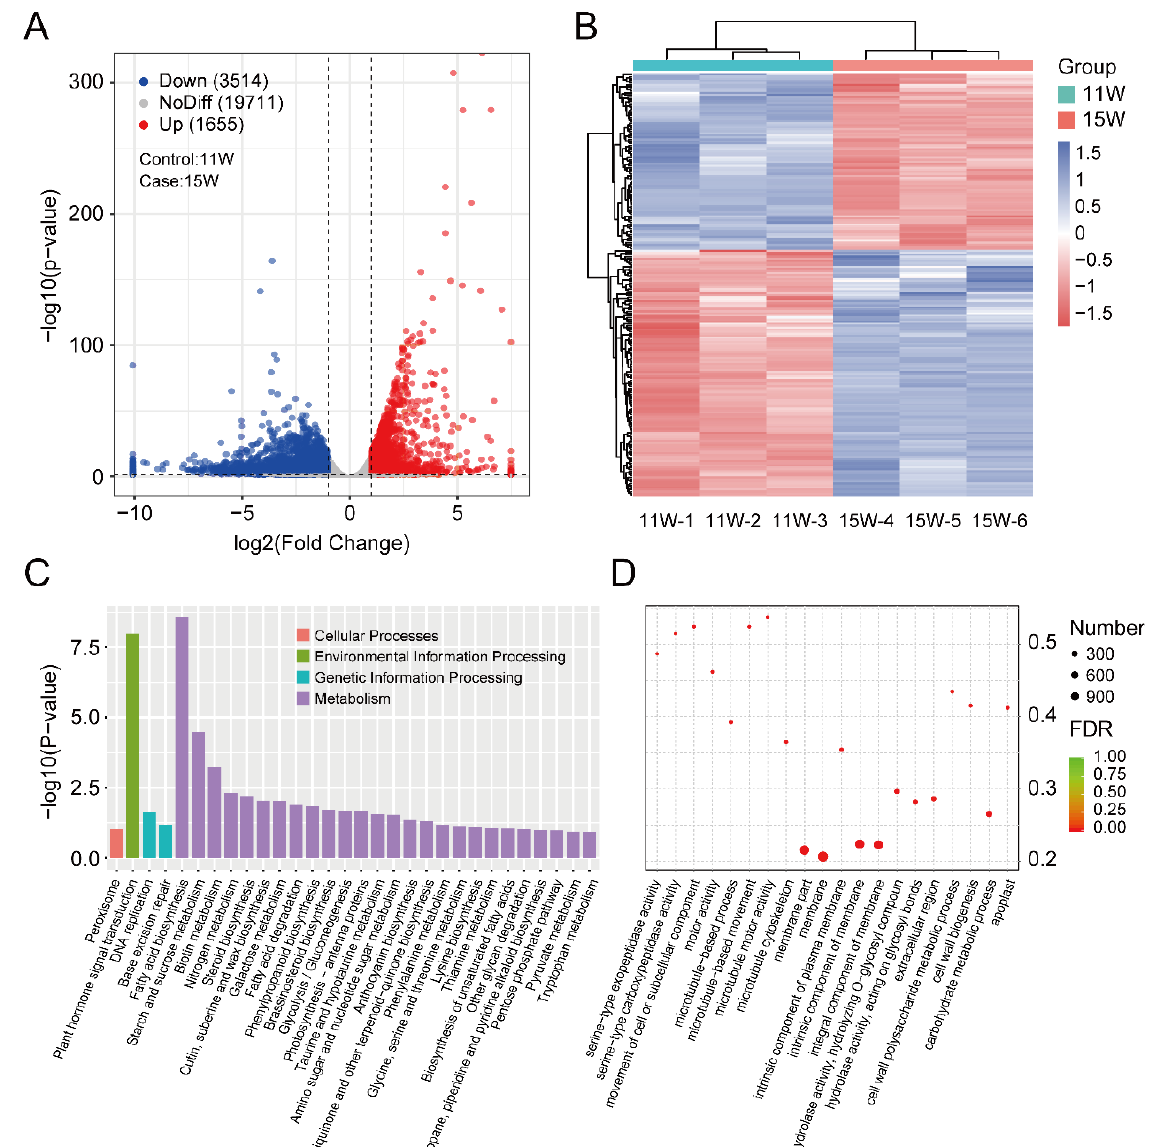
Figure 4. Identification of DEGs between 11W and 15W samples and functional enrichment analysis. ( A ) The volcano plot represents up- (red dots) and downregulated genes (blue dots), and no-difference expression genes (grey dots). Dotted lines show the DEG cutoff value of FC > 2 with p < 0.05; ( B ) the heatmap of Z-score-transformed gene expression level of DEGs; ( C ) histogram (right panel) representing significantly enriched gene ontology terms, which are divided into biological processes, molecular functions, and cellular component categories; ( D ) the bubble diagram shows the significantly enriched GO terms.